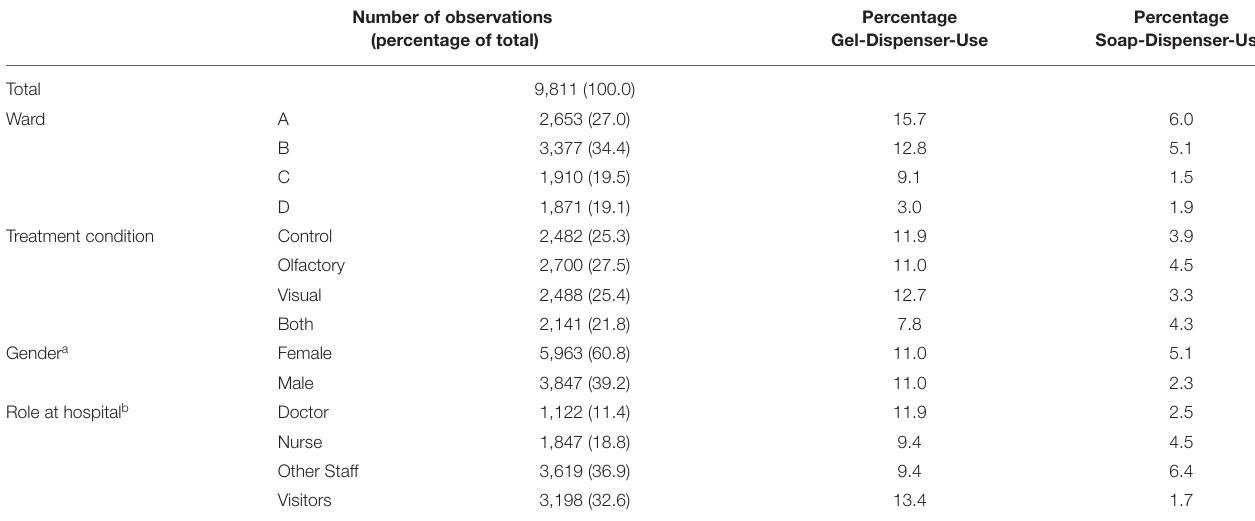
TABLE 2 | Descriptive statistics pertaining to the use of hand cleansing materials, broken down by ward, treatment condition, gender, and role at hospital.